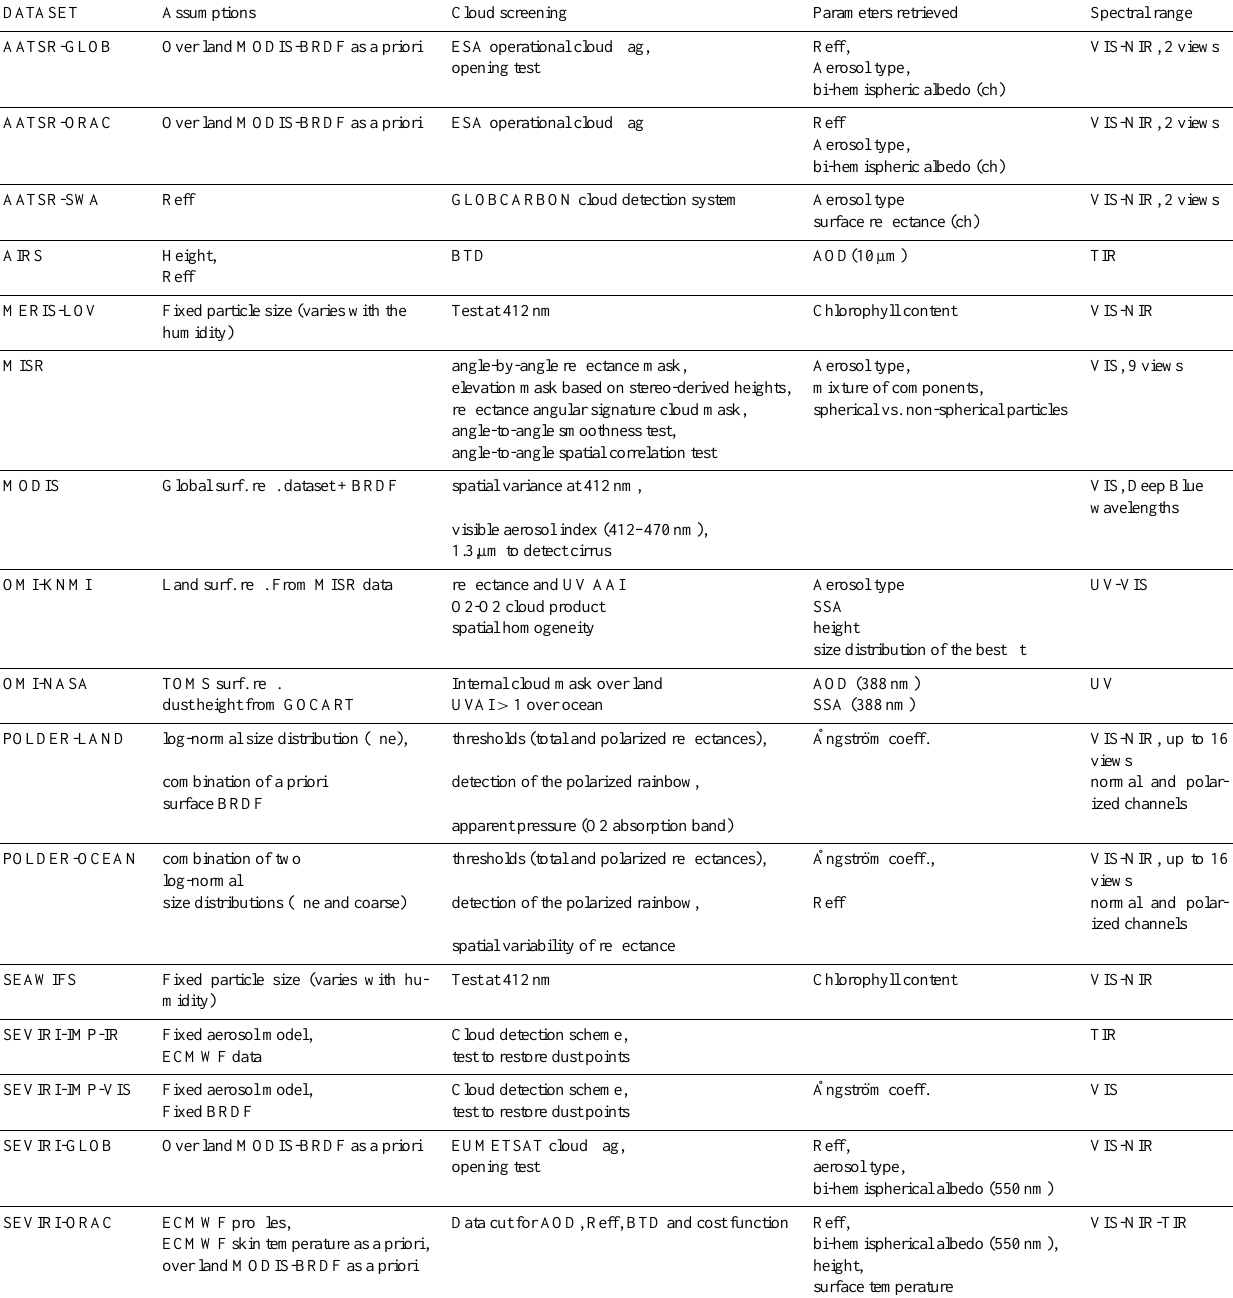
Table 2. Summary of dataset main characteristics: assumptions, cloud screening, retrieved parameters besides the AOD at 550nm and the spectral range together with other mean features of the instrument that have been used (for more details see individual algorithm description in Sect.